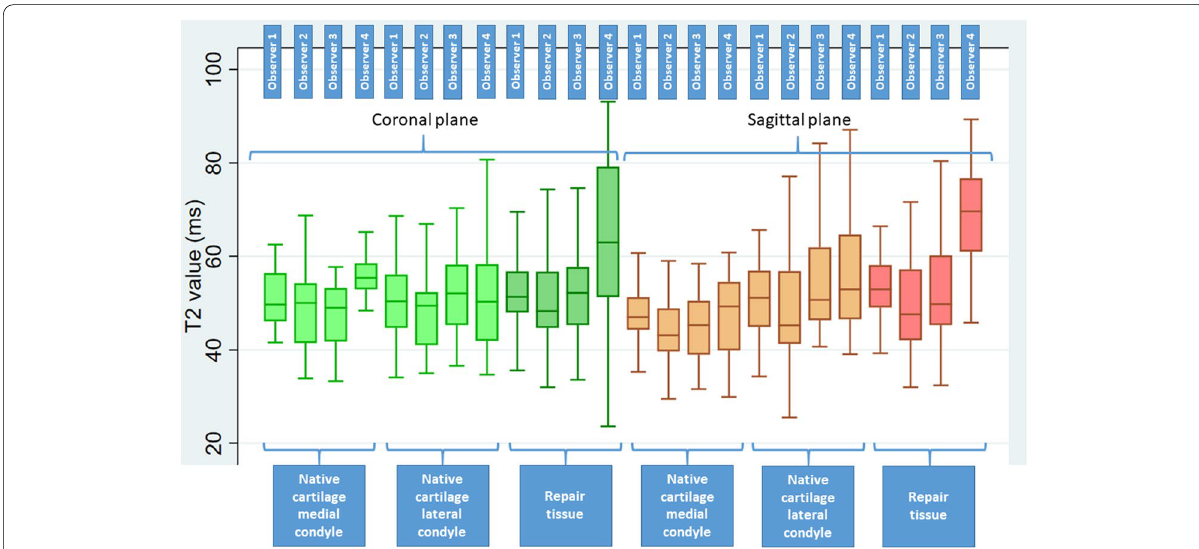
Fig. 4 Box plots demonstrating variability of the measured T2 values by the observers in coronal and sagittal planes, for native and repair cartilage